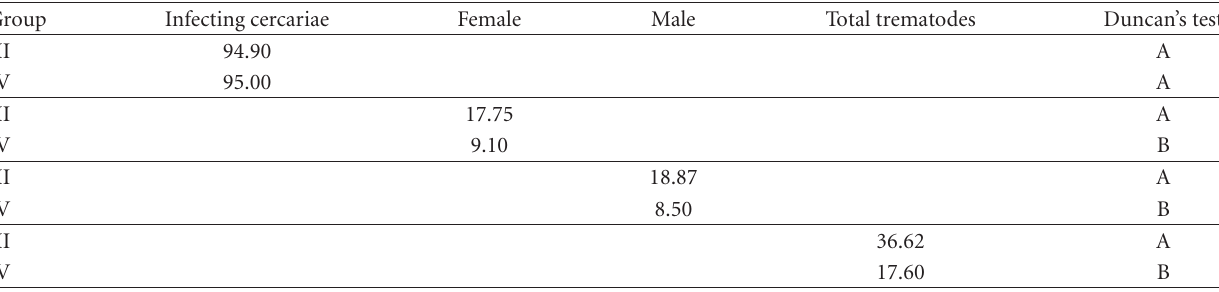
Table 1: The table presents the mean number of cercariae and male and female trematodes that were recovered from mice exposed to 100 cercariae of the S. mansoni BH strain and inoculated 8 weeks later with eggs from the S. mansoni BH (Group III) or SJ (Group IV) strains. The mice were euthanized 1, 8, 15, and 34 days after being inoculated with eggs in the caudal vein.